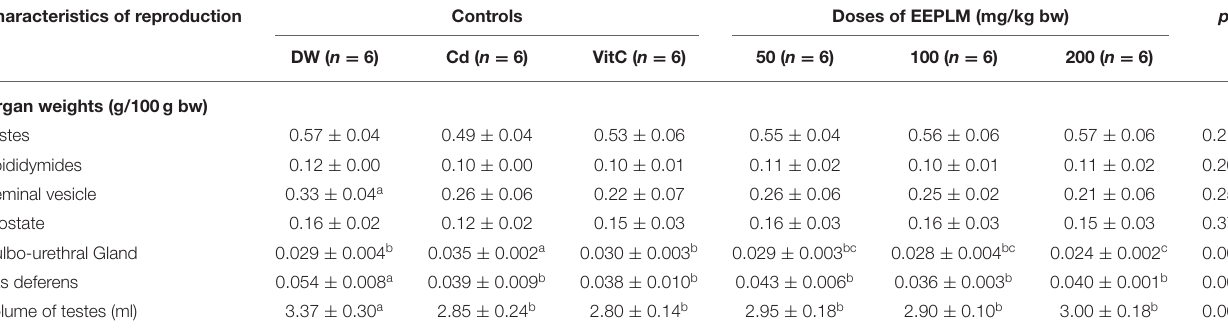
TABLE 2 | Effects of EEPLM on reproductive characteristics in male guinea pigs exposed to cadmium chloride. Characteristics of reproduction